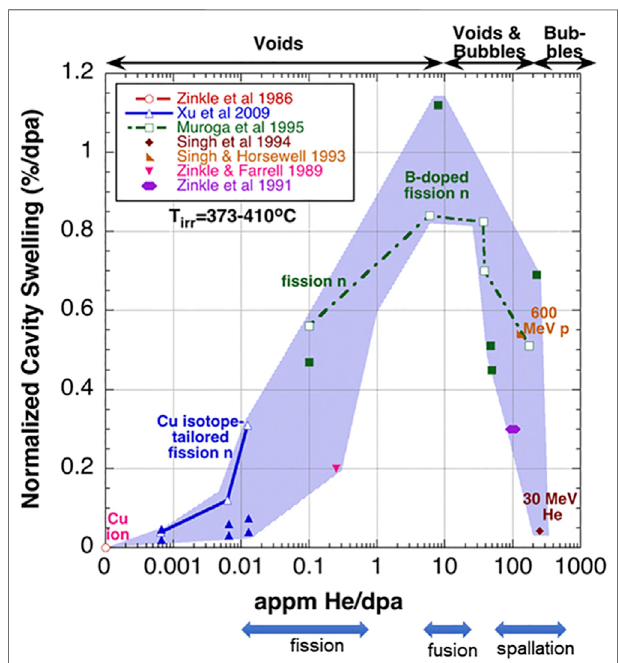
FIGURE 3 | Variation of irradiation hardening with dose induced by spallation and fi ssion neutron irradiation. As dose increases, the hardening induced by fi ssion neutron irradiation saturates, while that induced by spallation neutron irradiation do not saturate and reaches remarkable levels. (Dai et al.,